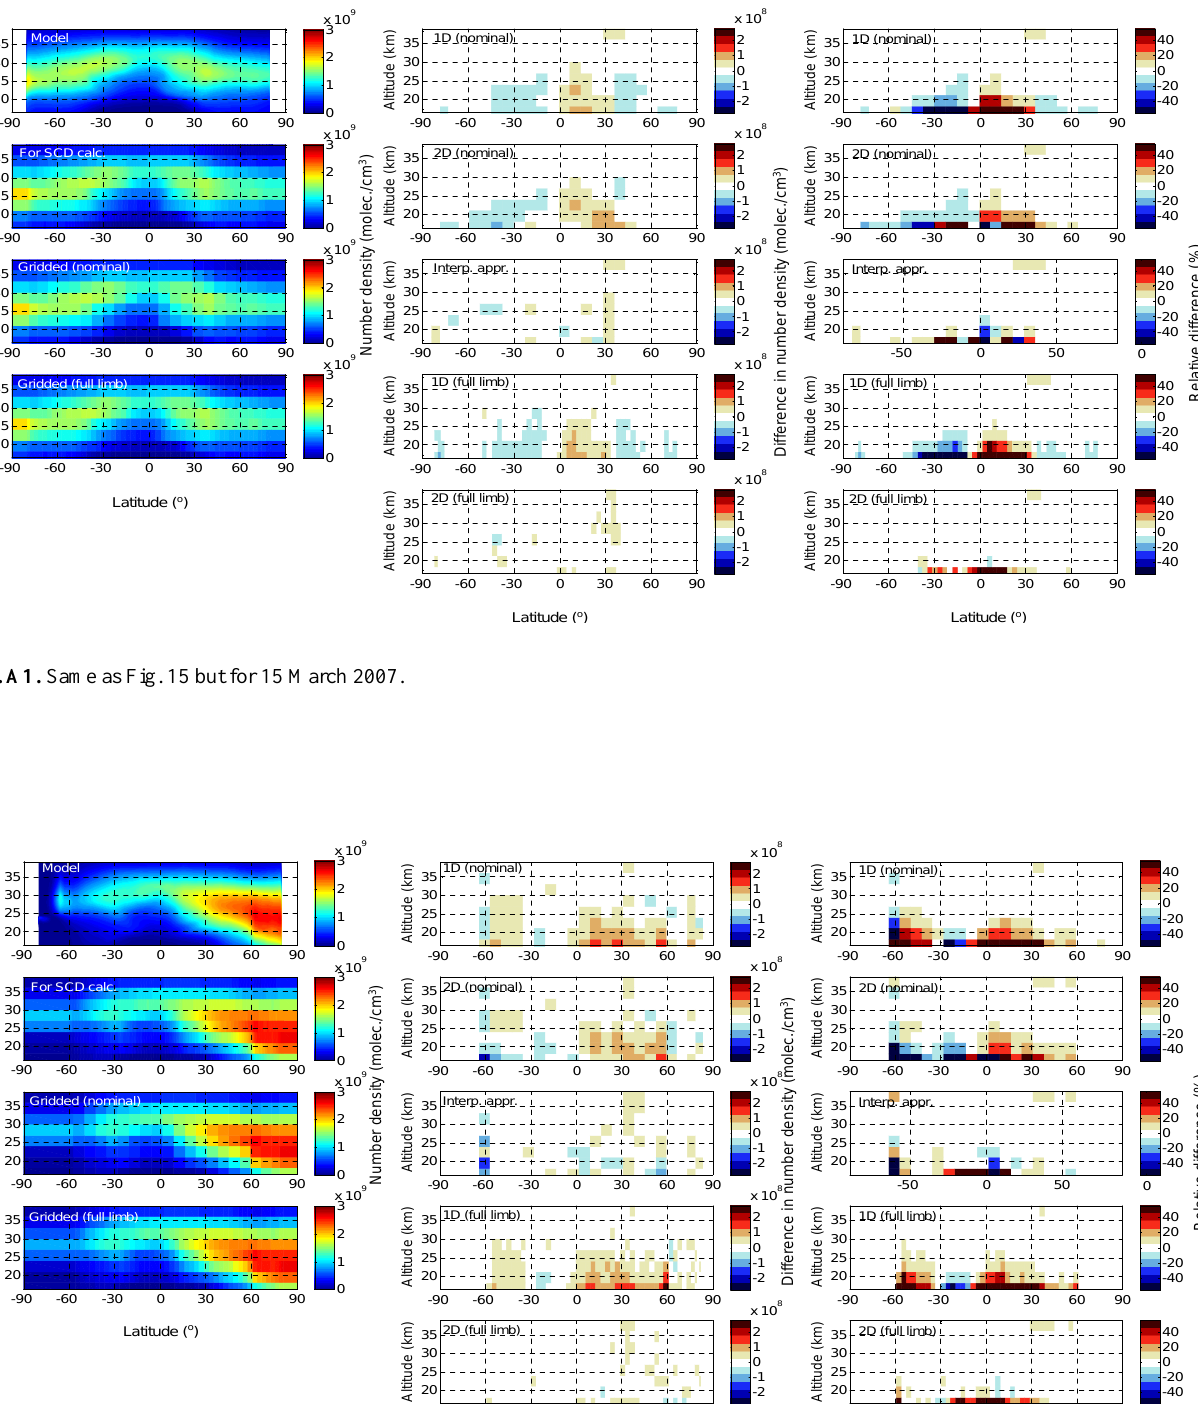
Fig. A2. Same as Fig. 15 but for 15 June 2007.